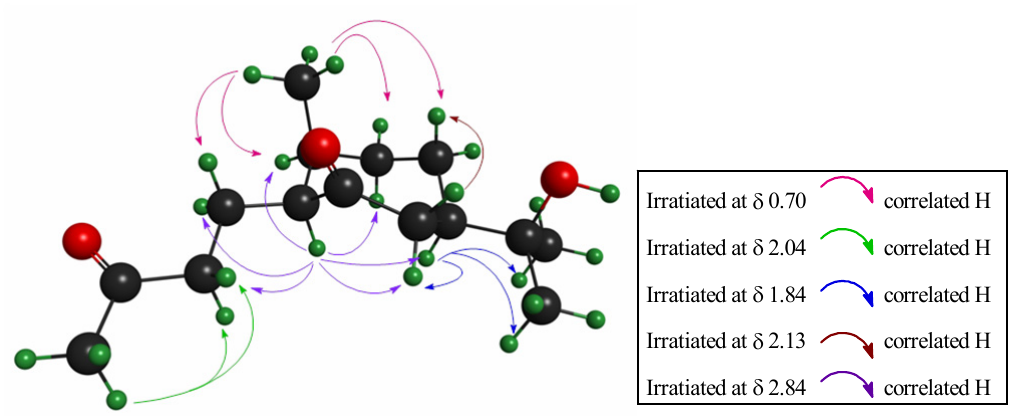
Figure 2. Selected nOe interactions for sesquiterpene 1